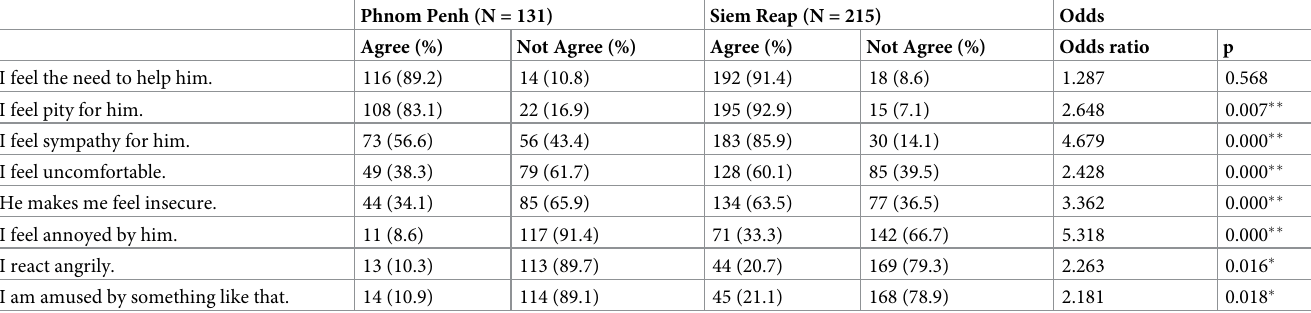
Table 5. Participants’ feelings about